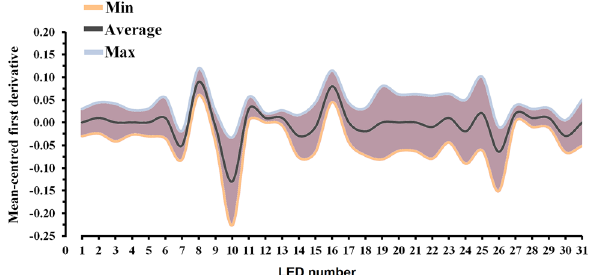
Figure 3. The average value for AfiLab milk spectra (solid black line represents the average, the purple region represents values inside mean ± 3*SD, the blue line represents the maximum value, and orange line the minimum value) that belonged to the considered Holstein–Friesian cows’ population (n = 385). LED light emitting